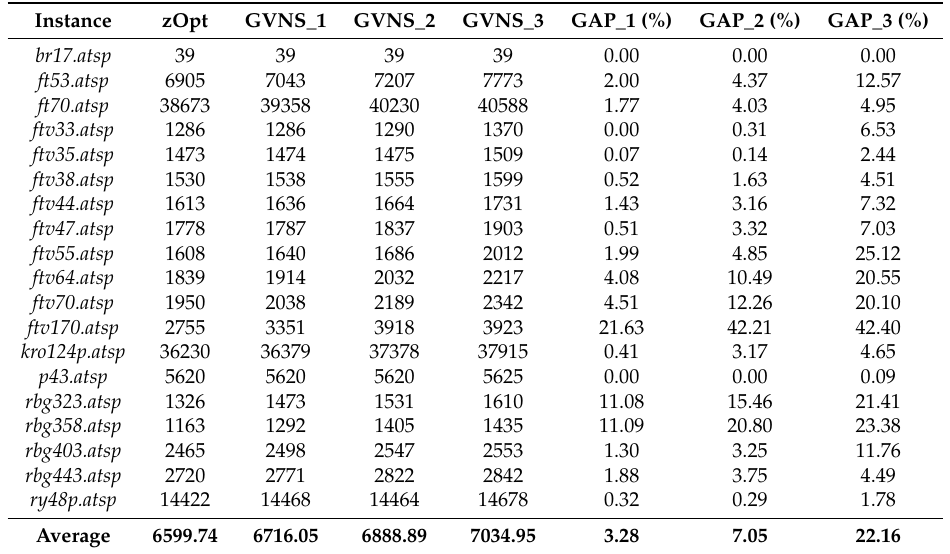
Table 4. Results using the Best Improvement search strategy and an execution time limit of 2 min [14]. Instance